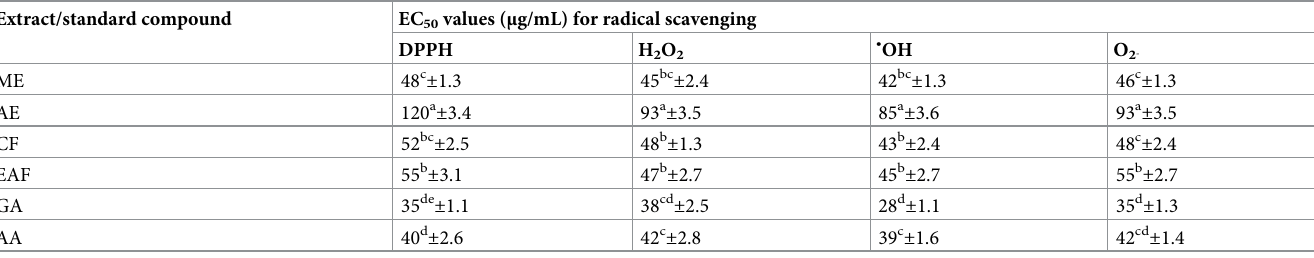
Table 4. Radical scavenging activities of J . mimosifolia leaf extracts and fractions. Extract/standard